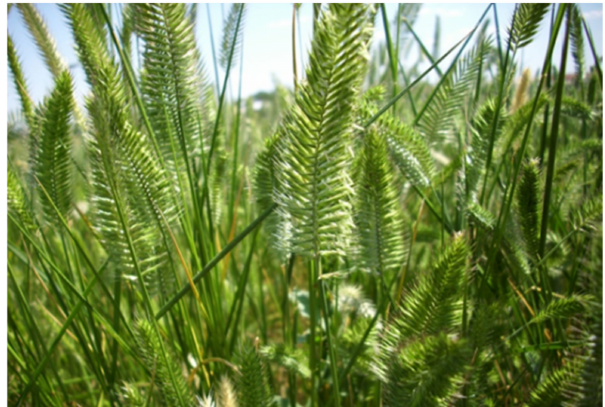
Figure 8. Standard wheatgrass ( Agropyron desertorum Fisch.) Variety Morava. Author’s photos